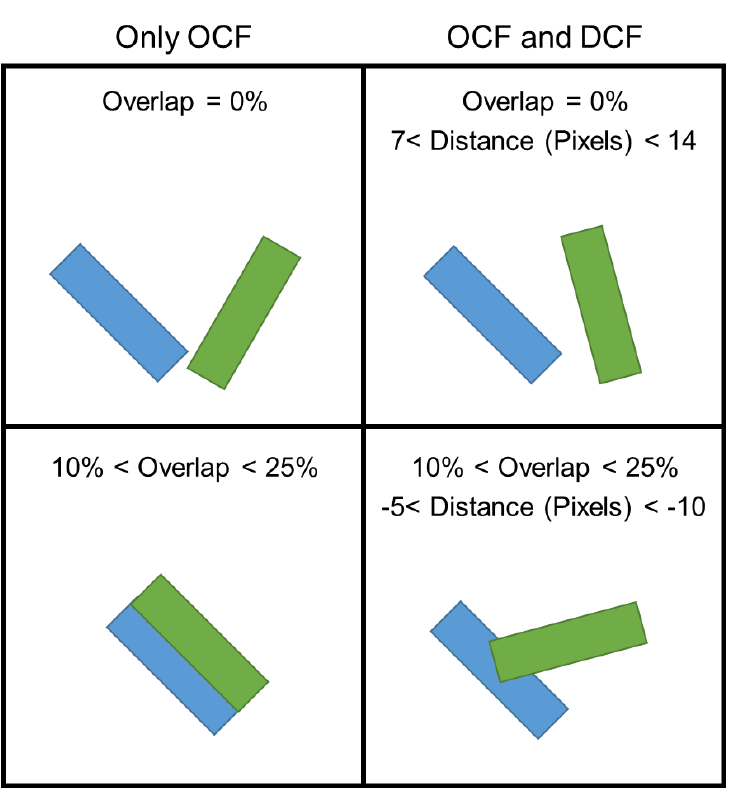
Figure 3. Examples illustrating various placement modes that can be achieved using an OCF and a DCF in conjunction. For each example, the blue rectangle is already in the microstructure, and the green rectangle is to be